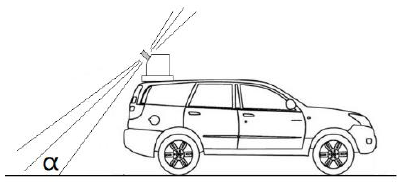
Figure 2. Scanning surface of vehicle-borne scanning system.